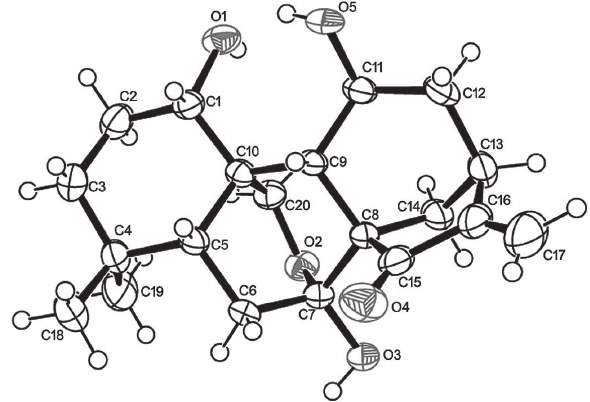
Table 1: Data collection and handling.